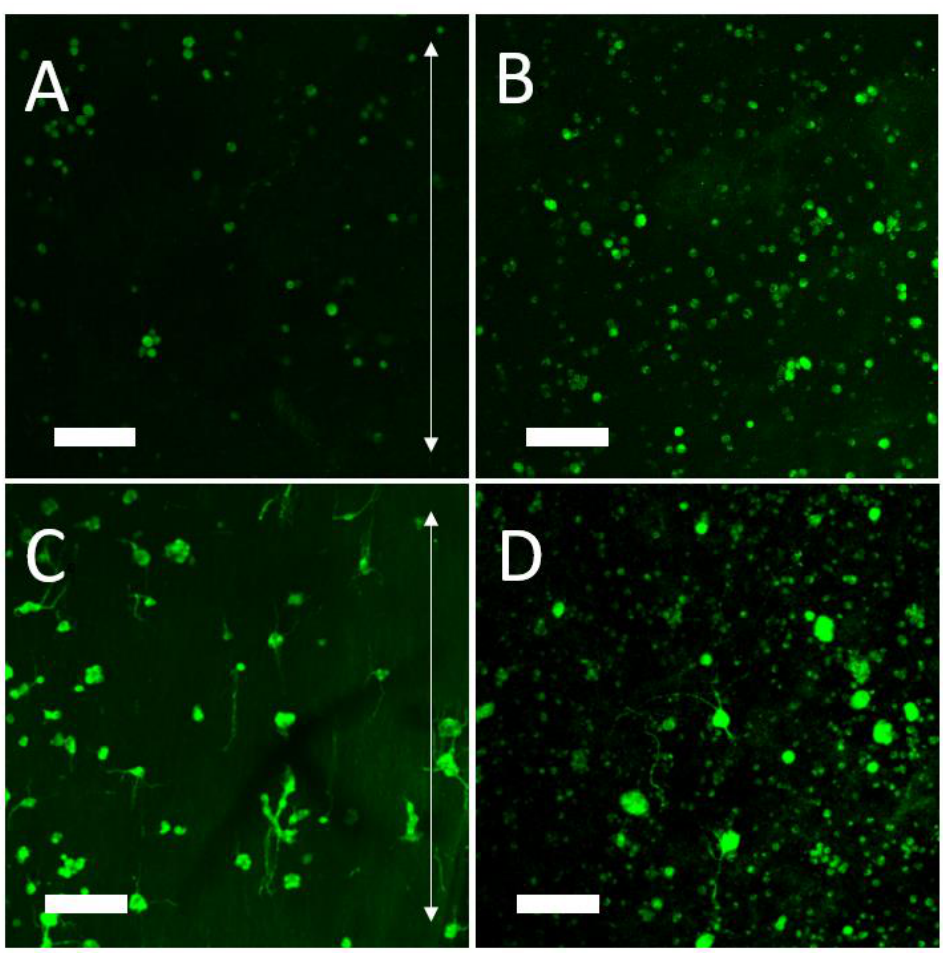
Figure 9. Neurite extension of PC12 cells in the composite electrospun nonwoven-hydrogel scaffold. PC12 cells were mixed with collagen-GMA hydrogel-forming solution, pipetted on top of electrospun PCL/P 11 -8 nonwoven, UV-irradiated for 10 min and placed into an incubator at 37 °C/5% CO 2 for 7 days. Immediately after incubation cells were observed on both the ( A ) surface of electrospun PCL/P 11 -8 and ( B ) at least 50 µm away from the nonwoven surrounded by collagen-GMA hydrogel. Following 7 days of NGF exposure, ( C ) PC12 cells in contact with the nonwoven surface were observed extending neurite in the direction of fibre alignment, whilst ( D ) away from the nonwoven surface, cells were observed extending neurites in a random orientation. Arrows show direction of alignment. Scale bar is 100 µm.